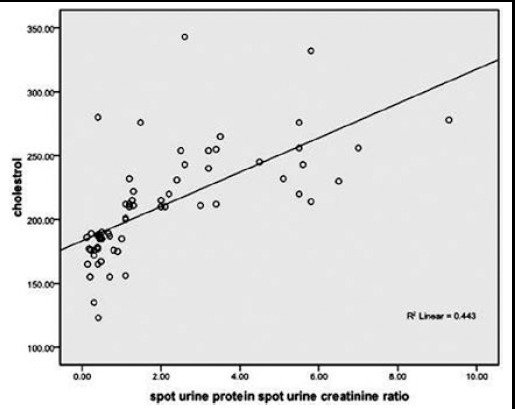
Correlation of cholesterol and Proteinuria.